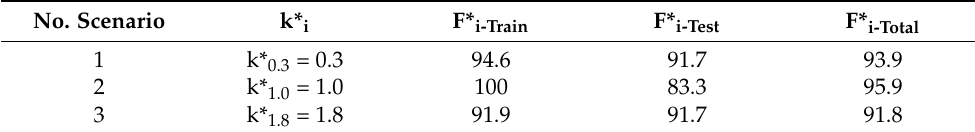
Table 4. Values of F* i,Train , F* i,Test and F* i,Total assuming k* 0.3 = 0.3, k* 1.0 = 1.0 and k* 1.8 = 1.8. No.